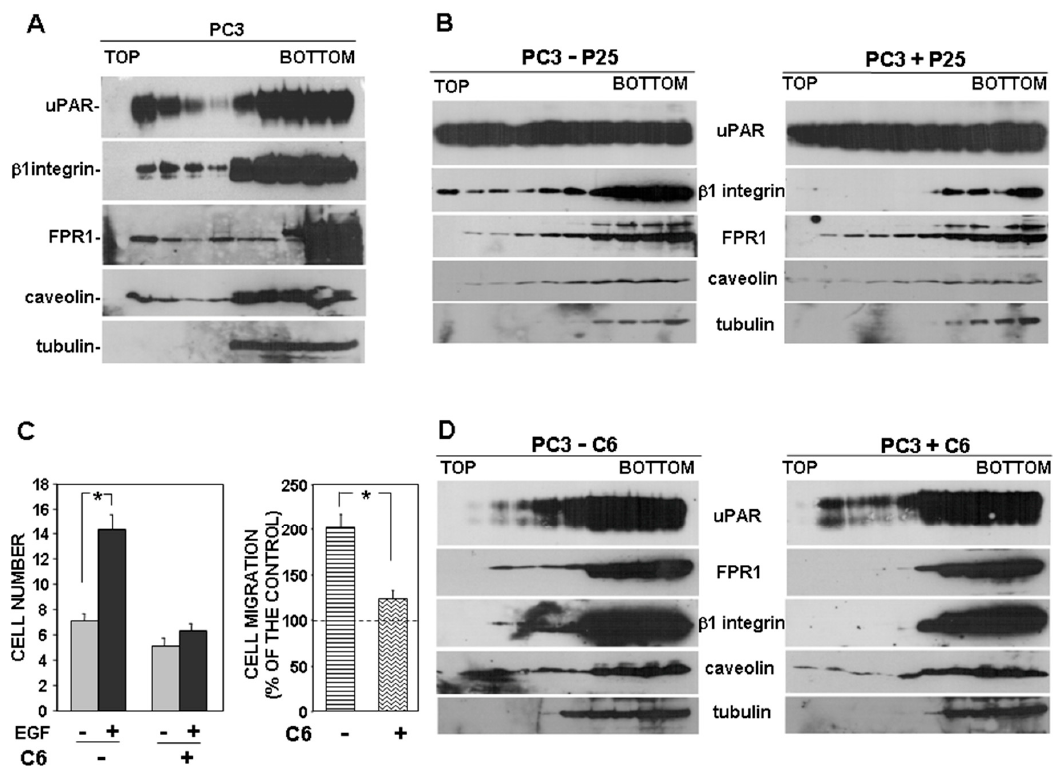
Figure 5. uPAR drives its signaling partners to lipid rafts. Cultured PC3 cells ( A ) or PC3 cells treated with 50 µ M P25 or with its scrambled version ( − ) ( B ) were lysed in bu ff er containing 1% Triton X-100. Cell lysates were loaded onto a sucrose density gradient and subjected to ultracentrifugation. Then, 4.5 mL were harvested as 0.45 mL fractions; 45 µ L of each fraction was analyzed by Western blot with the indicated antibodies; tubulin and caveolin were used as controls of non-raft associated proteins or raft associated proteins, respectively. ( C ) PC3 cells were pre-incubated with or without 50 µ M C6 compound, then plated in Boyden chambers and allowed to migrate toward 100 ng / mL EGF Epidermal Growth Factor (EGF). Migrated cells were fixed, stained with hematoxylin, and counted (left panel). Results of migration assays are also expressed as percentage of cells migrated towards serum over the cells migrated without serum; 100% values represent cell migration in the absence of chemoattractants (right panels). The values are the mean + SD of three experiments performed in triplicate. (*) p < 0.05, as determined by the Student’s t -test. C6 treated or untreated cells were also lysed in bu ff er containing 1% Triton X-100, loaded onto a sucrose density gradient and subjected to ultracentrifugation. Then, 45 µ L of each gradient fraction was analyzed by Western blot with the indicated antibodies; tubulin and caveolin were used as control of non-raft associated proteins and raft associated proteins, respectively ( D